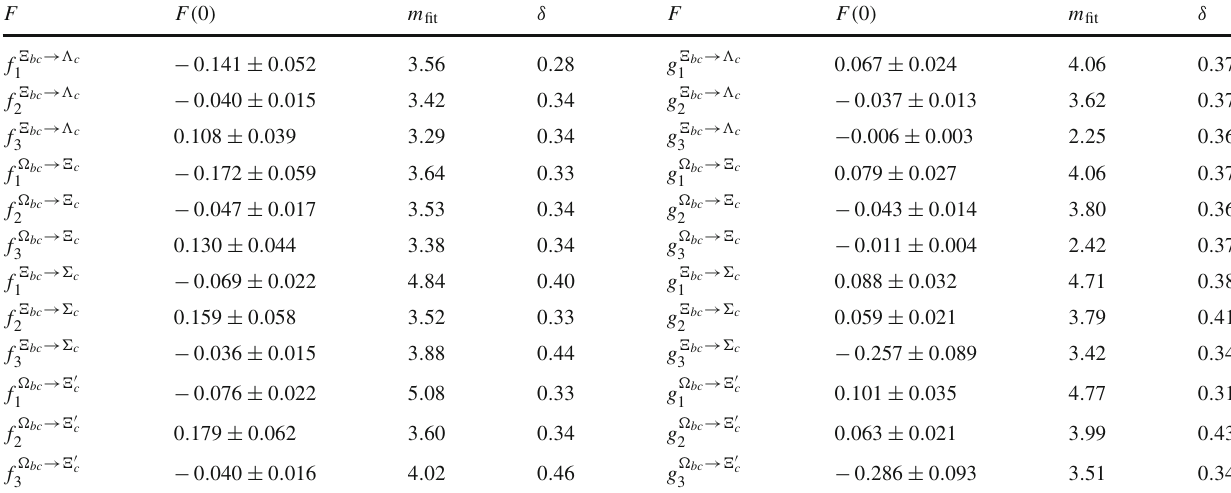
Table 11 The form factors for the bc sector with b quark decay. Equa- tion (37) is adopted as the fit formula. The results for (cid:2) bc → (cid:6) c √ → (cid:6) + correspond to (cid:2) 0 2 should be multiplied to F ( 0 ) c . A factor bc